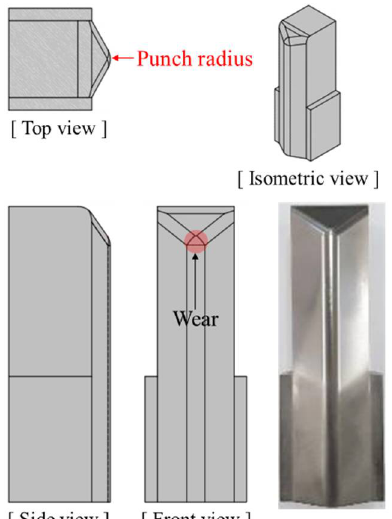
Figure 2. Punch geometry used for the wear test, which is designed to localize wear to the punch radius, as proposed by Bang et al. [35].